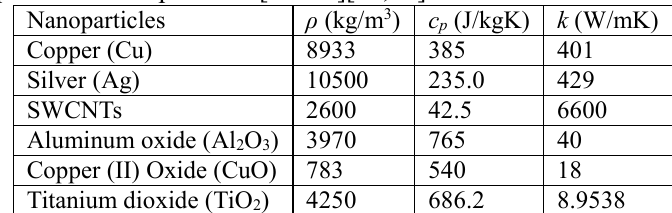
Thermal-physical properties of nanoparticles [39–41][50,51].